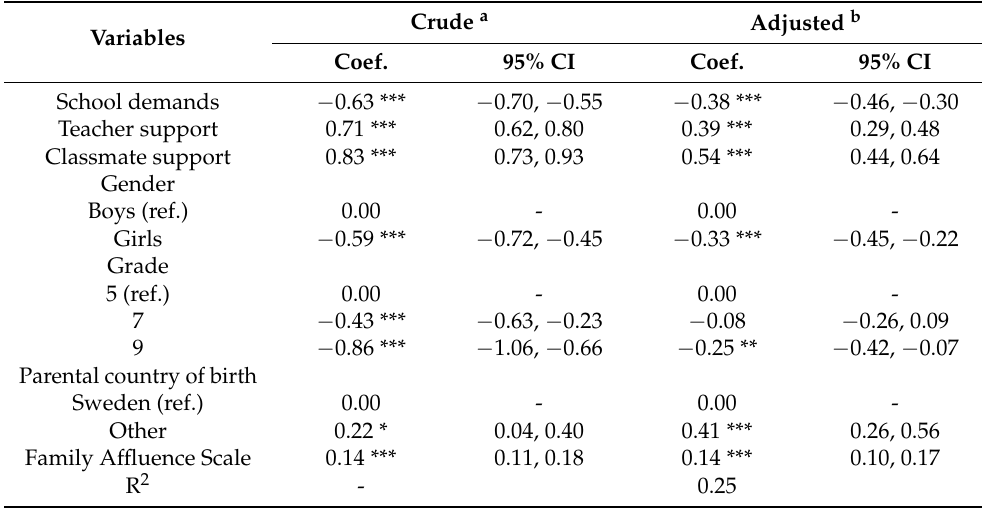
Table A2. Coefficients and 95% confidence intervals from linear regressions of life